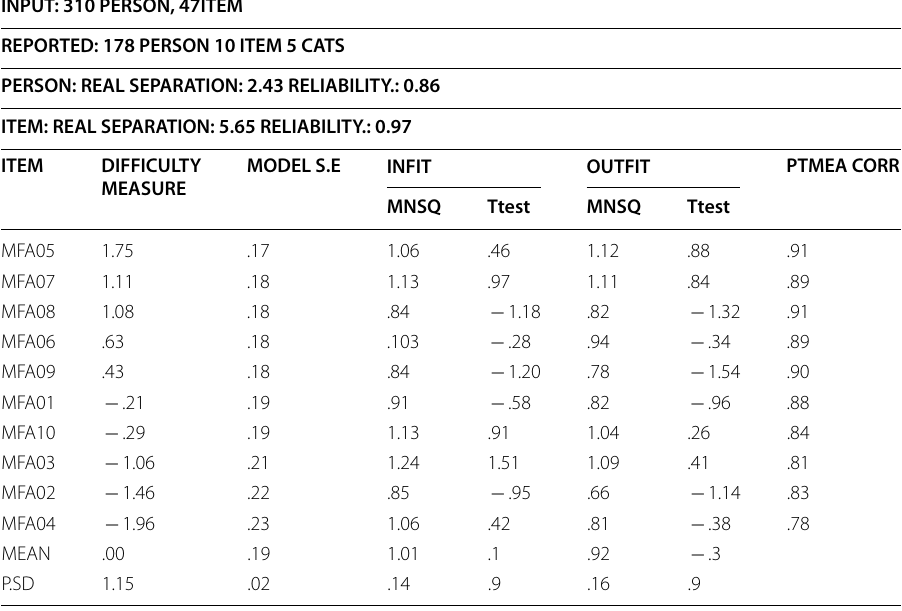
Table 7 Dimension MFA: Item difficulties, standard errors, Infit, Outfit, T-test and correlations, estimated from final